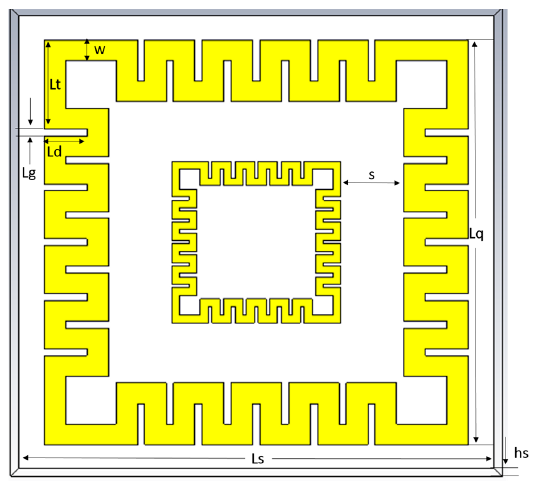
Figure 2. Meander-line nested square structure dimensions.